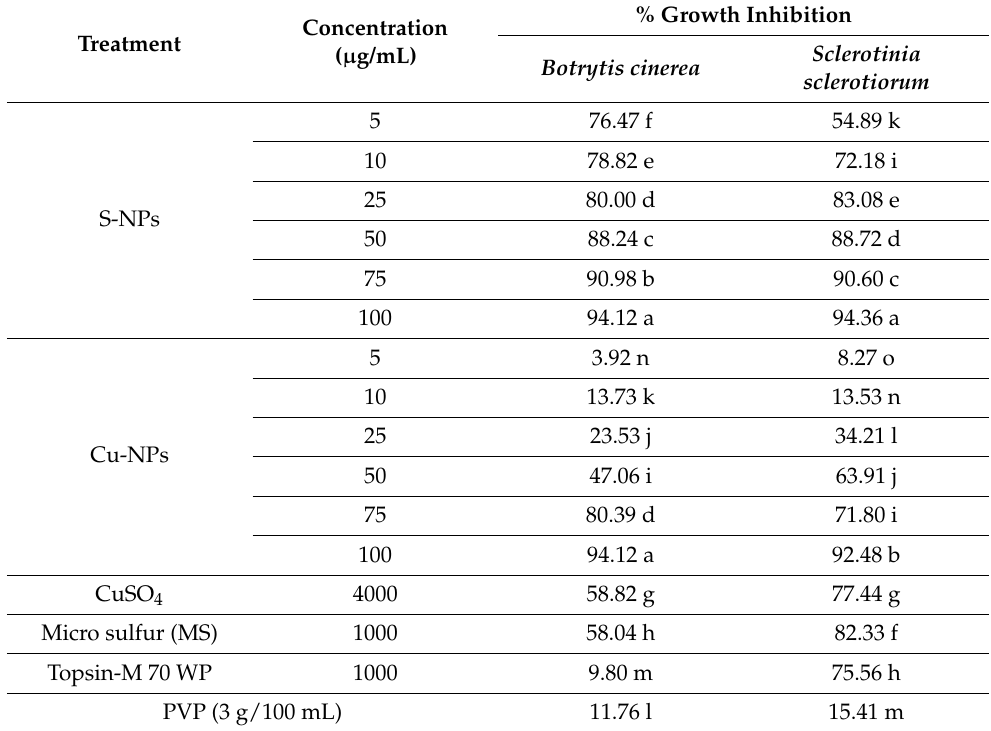
Table 1. Ouda studied the effect of Cu-NP concentration on the growth of B. cinerea and reported that the pathogen growth was minimized with the increase in Cu-NPs from 1 to 15 µ g/mL which confirmed the obtained results in this study [46]. Table 1. Effect of Cu-NPs and S-NPs at different concentrations on B. cinerea and S. sclerotiorum growth on PDA. % Growth Inhibition Concentration Treatment Sclerotinia ( µ g/mL) Botrytis cinerea sclerotiorum 5 76.47 f 54.89 k S-NPs